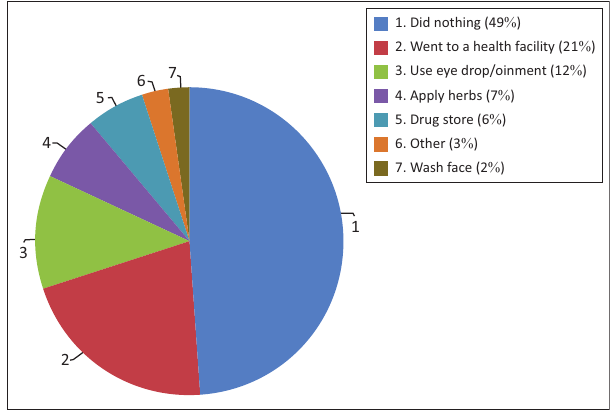
FIGURE 1: Initial action taken in managing eye